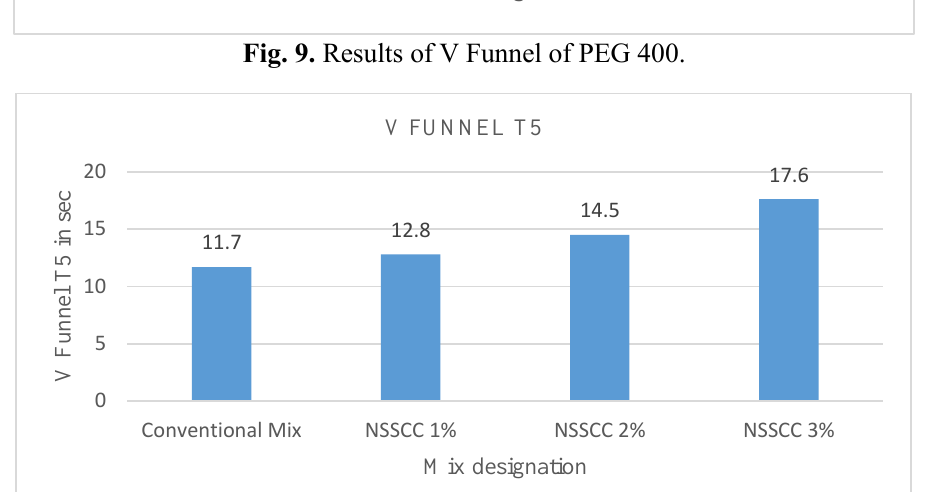
Fig. 9. Results of V Funnel of PEG 400.